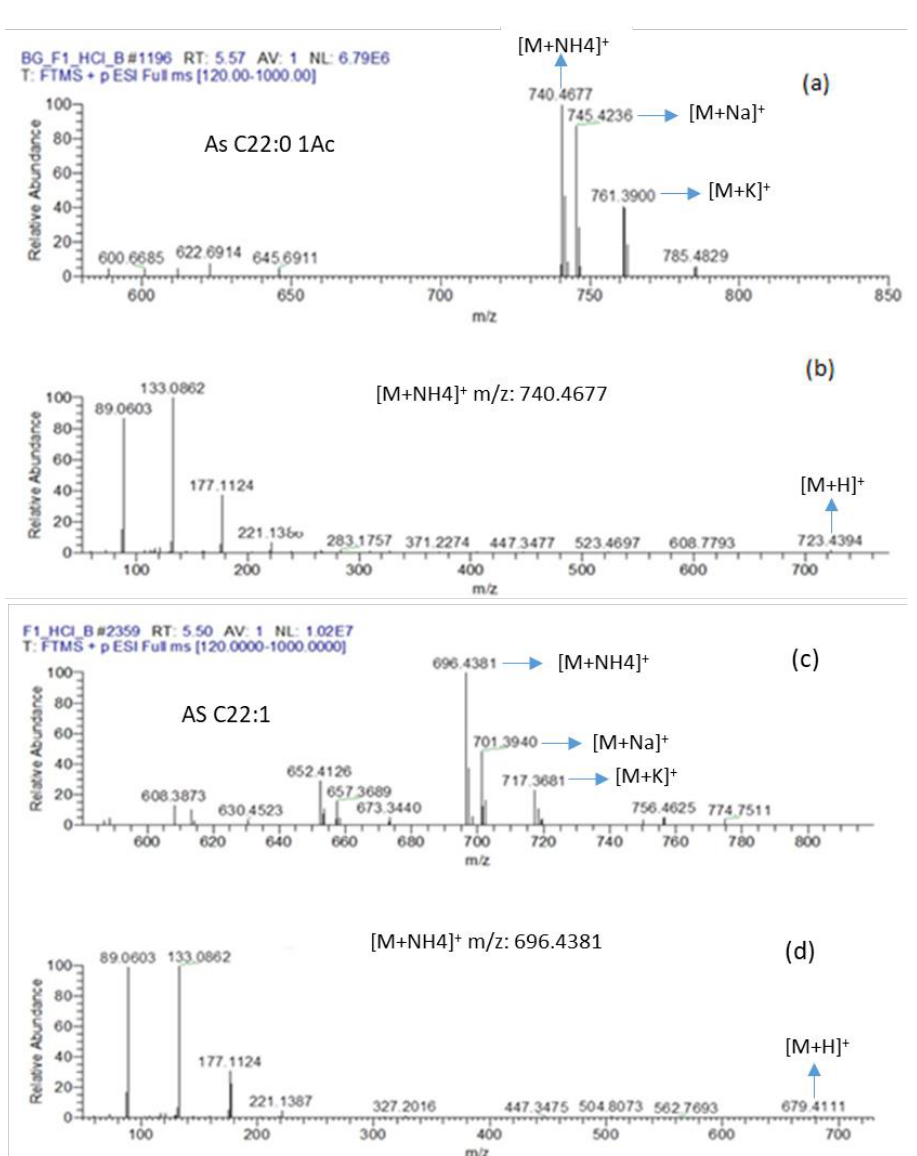
Figure 4. Full scan LC-MS mass spectrum of the R. rubra extract with antibacterial activity under culture conditions LFR 40% v / v , without yeast extract, seawater 80% v / v , incubation temperature of 15 ◦ C and incubation time of 3 days. ( a ) m / z for AS C22:0-1AC; ( b ) confirmatory mass spectrum for the fragmentation of [M + NH4] + m / z : 740.4656; ( c ) m / z for AS C22:1 and ( d ) confirmatory mass spectrum for the fragmentation of [M + NH4] + m / z : 696.4403. AS: acidic sophorolipid; AC: acetyl group.